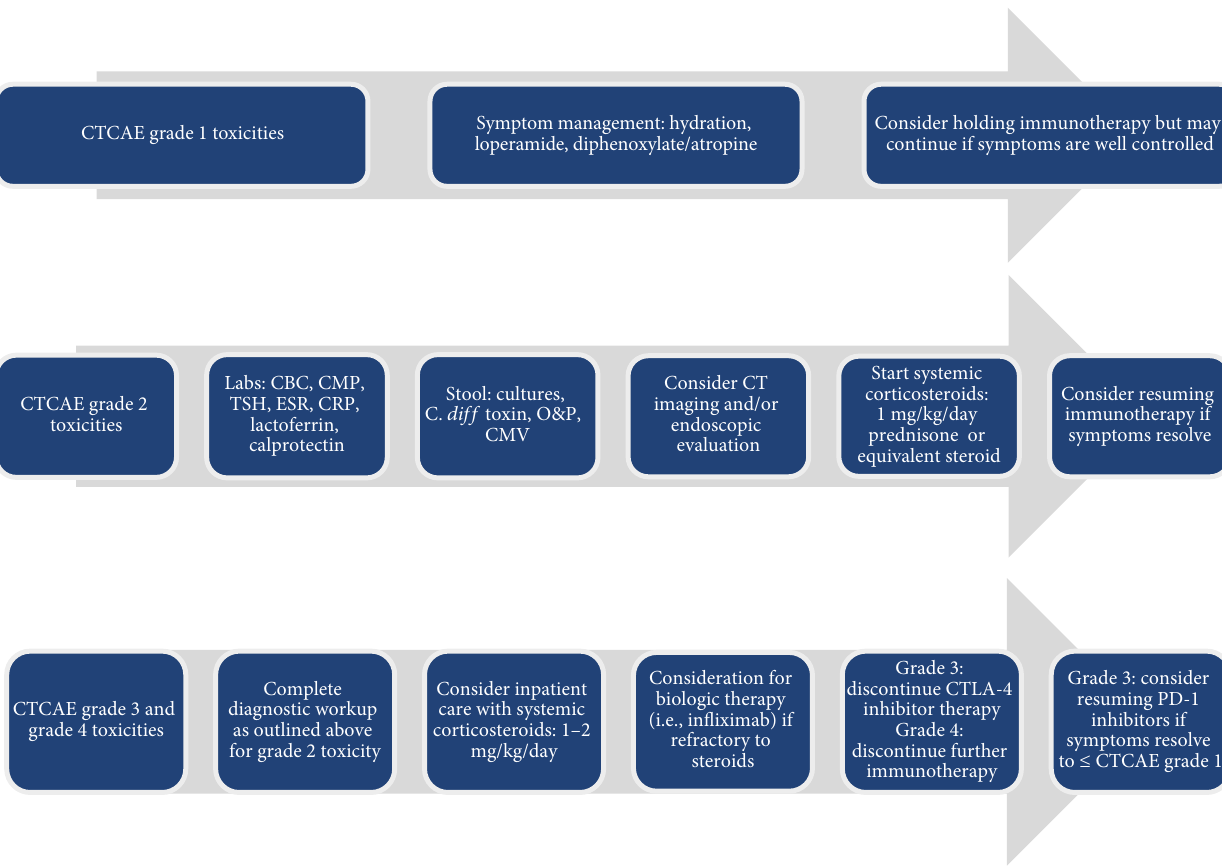
Figure 2: Recommended work fl ow for gastrointestinal toxicities. Abbreviations: CBC: complete blood count; CMP: complete metabolic panel; TSH: thyroid-stimulating hormone; ESR: erythrocyte sedimentation rate; CRP: C-reactive protein; C. di ff : Clostridium di ffi cile ; O&P: ova and parasites; CT: computed tomography; CTLA-4: cytotoxic T-lymphocyte antigen-4; PD-1: programmed